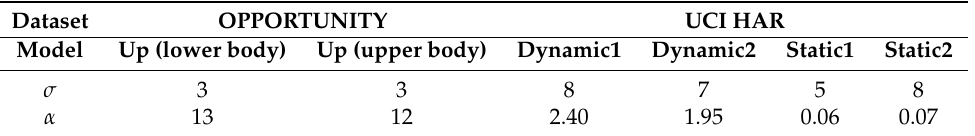
Table 3. Test data sharpening parameter values used in evaluation